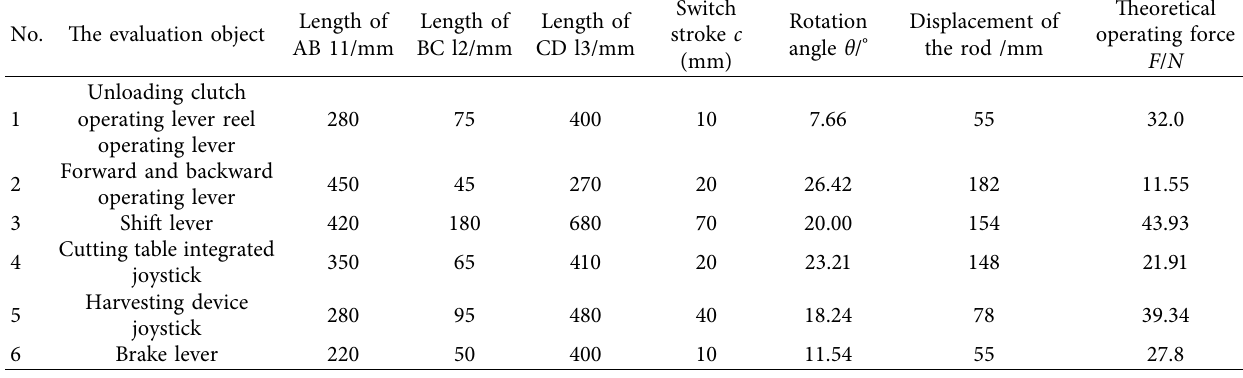
Table 4: Design variable and theoretical operating force of the joystick.